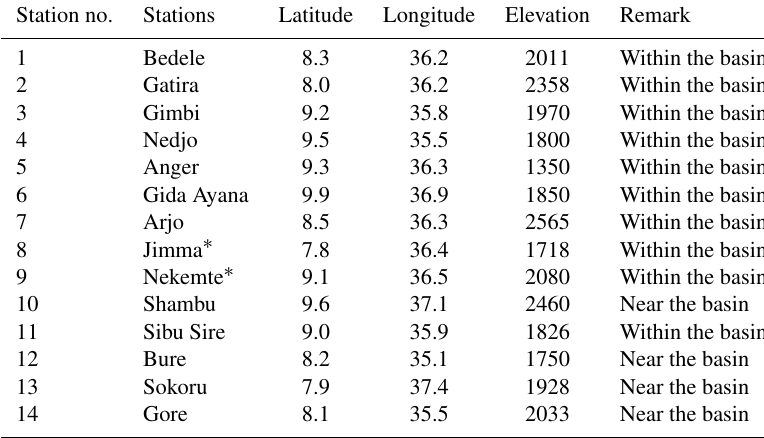
Table A1. List of rain gauge stations used for SRE